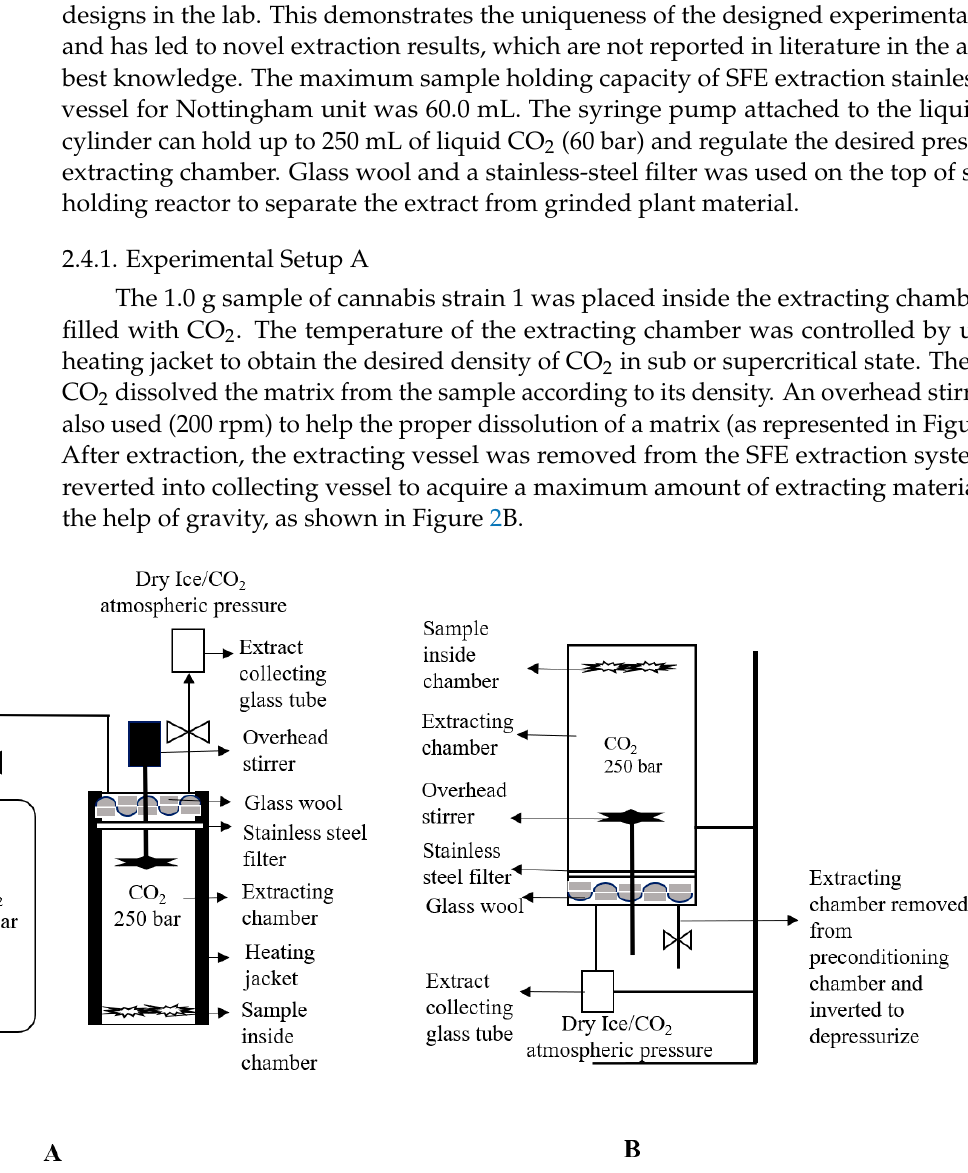
Figure 2. Schematic representation of the SFE Nottingham unit for the experimental setup A ( A ); Sample containing chamber was inverted and placed on stirrer for the depressurization ( B ).